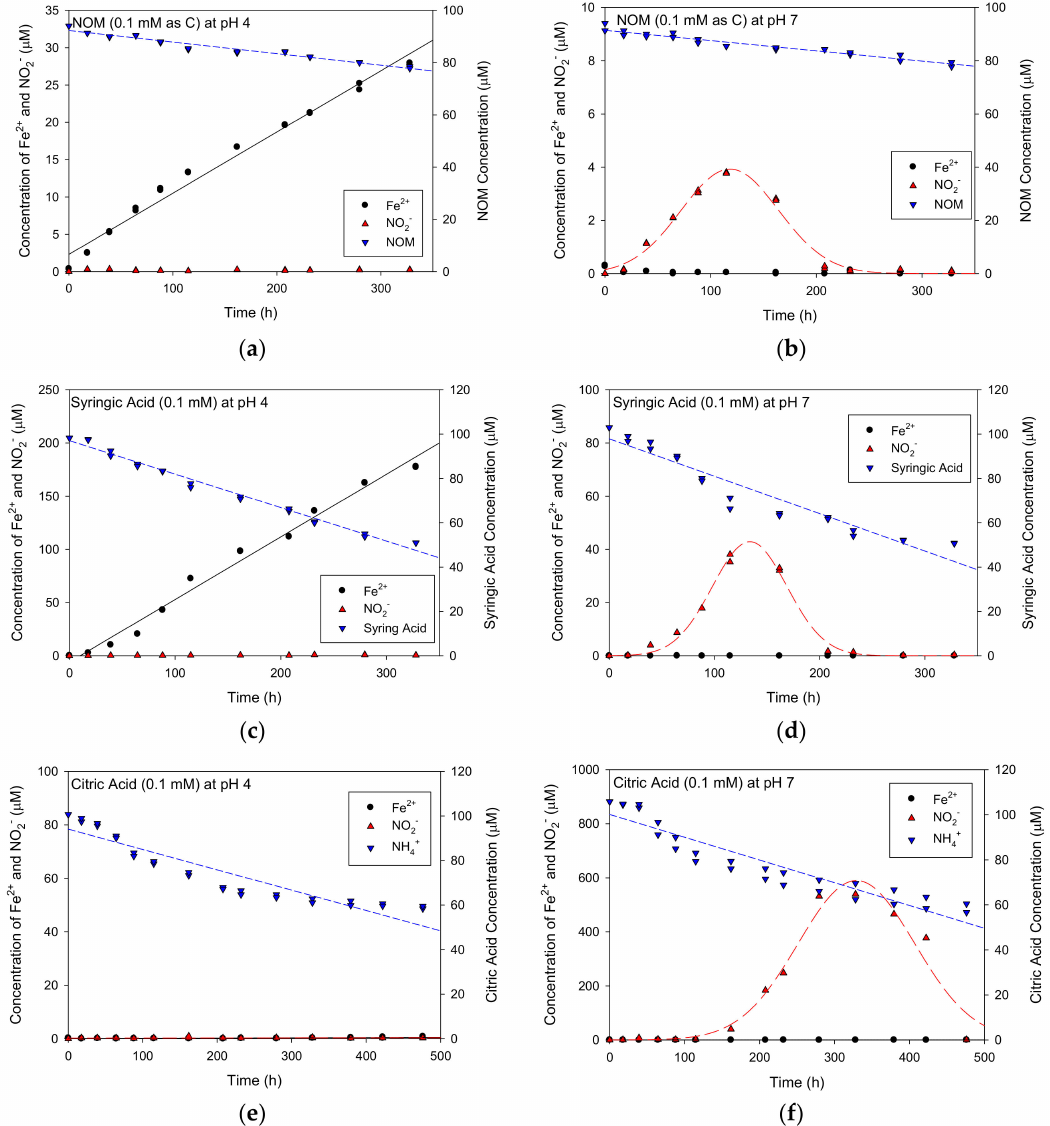
Figure 3. Fe 2 + and NO 2 − concentrations via time throughout Fe(II) / Fe(III) cycle with natural organic matter (NOM), syringic acid and citric acid at pH 4 and 7: ( a ) for NOM at pH 4; ( b ) for NOM at pH 7; ( c ) for syringic acid at pH 4; ( d ) for syringic acid at pH 7; ( e ) for citric acid at pH 4; ( f ) for citric acid at pH